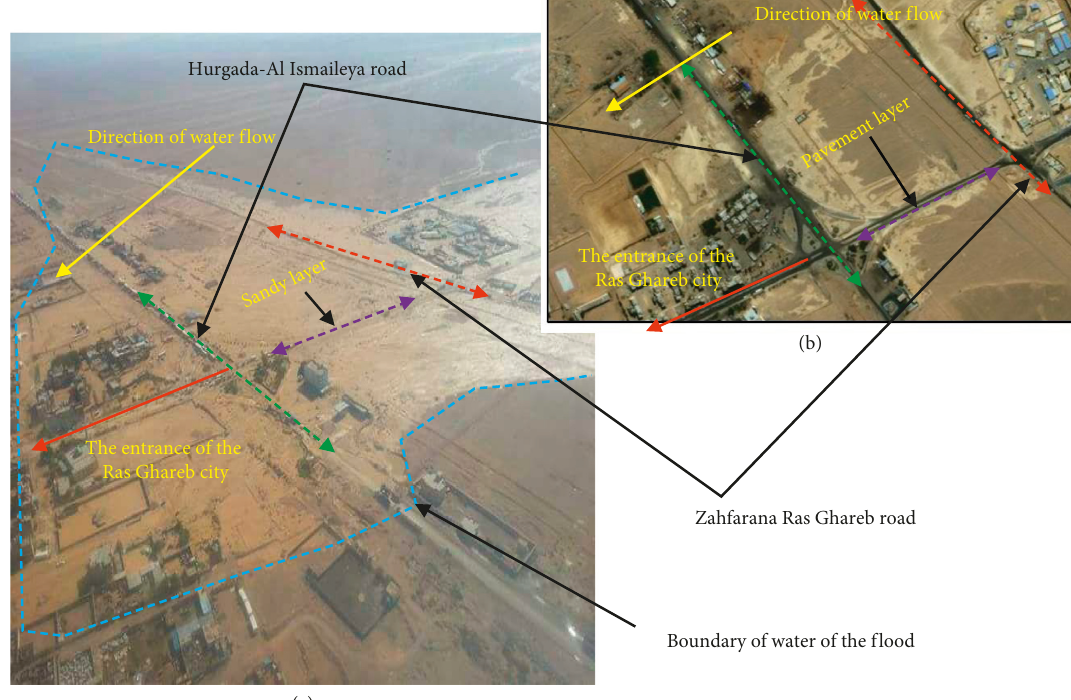
Figure 5: (a) A helicopter image captured on 28/10/2016 aerial view of the flooded area found on the webpage https://www.almasryalyoum. com/news/details/1031509. (b) The damage information extracted from the helicopter image which overlaid Google Earth images.